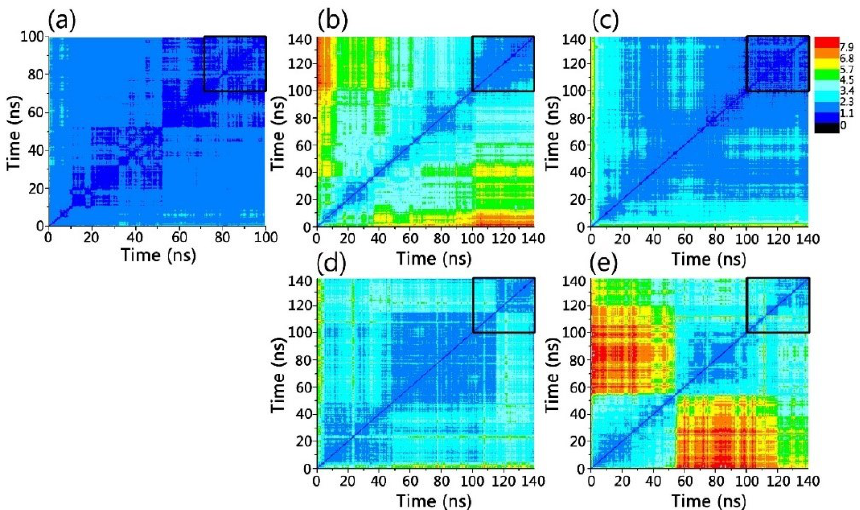
Figure 2. Two-dimensional root-mean-square deviation (2D-RMSD) matrix indicated that simulated system reached conformation equilibrium in 100–140 ns simulations. ( a ) gammabody; ( b ) 2U_Backbone; ( c ) 2U_SideChain; ( d ) 3S_Backbone; and ( e ) 3S_SideChain gammabody-A β complexes. The black boxes at the top right corner highlight the RMSD values in the equilibrium